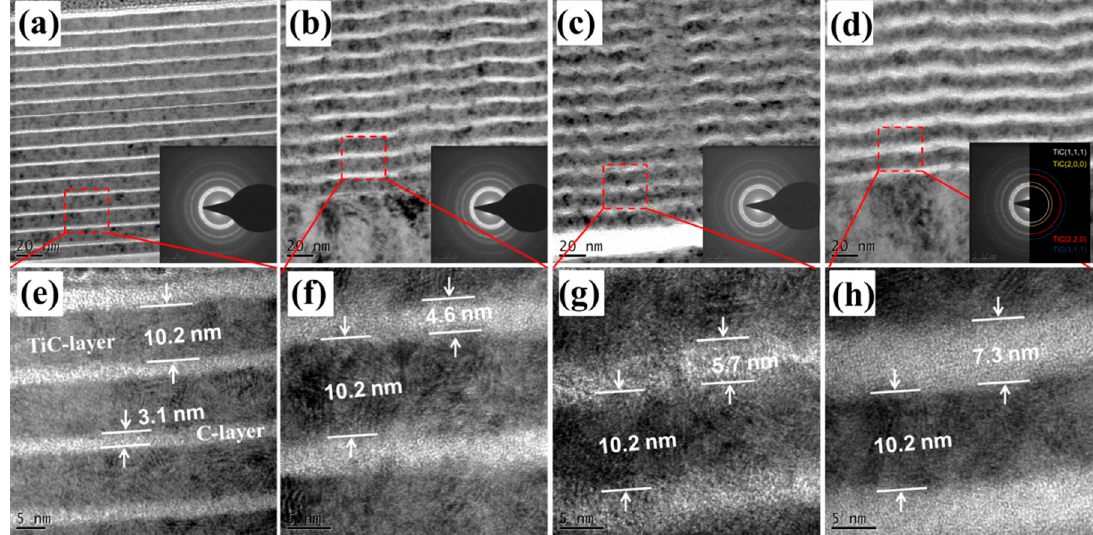
Figure 4. Cross-section TEM morphologies with inserted corresponding SAED pattern and HRTEM images of the films with different sputtering currents of graphite: ( a , e ) 6 A; ( b , f ) 8 A; ( c , g ) 10 A and ( d , h ), 12 A respectively.